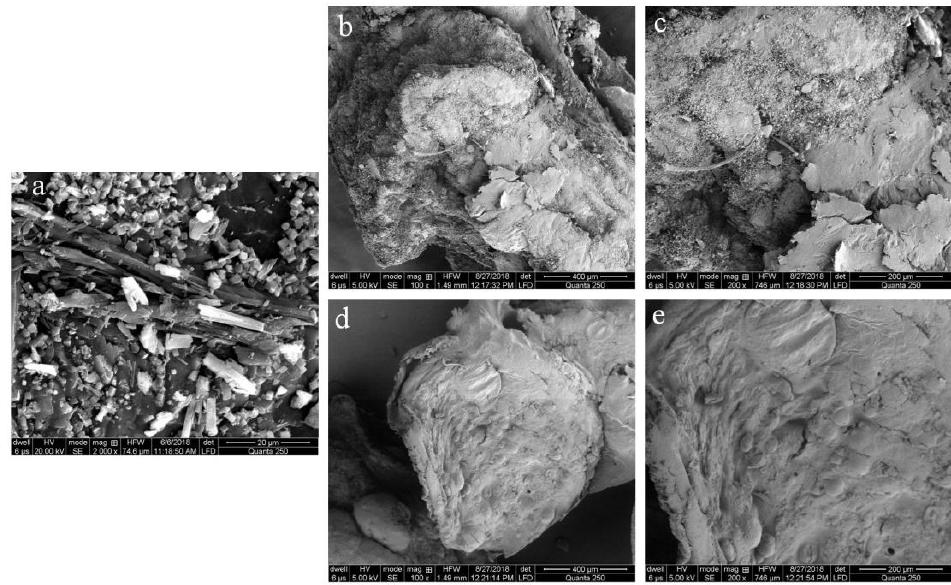
Figure 5. SEM microphotograph of ( a ) clarithromycin, ( b , c ) CLM3, and ( d , e ) CLM6.